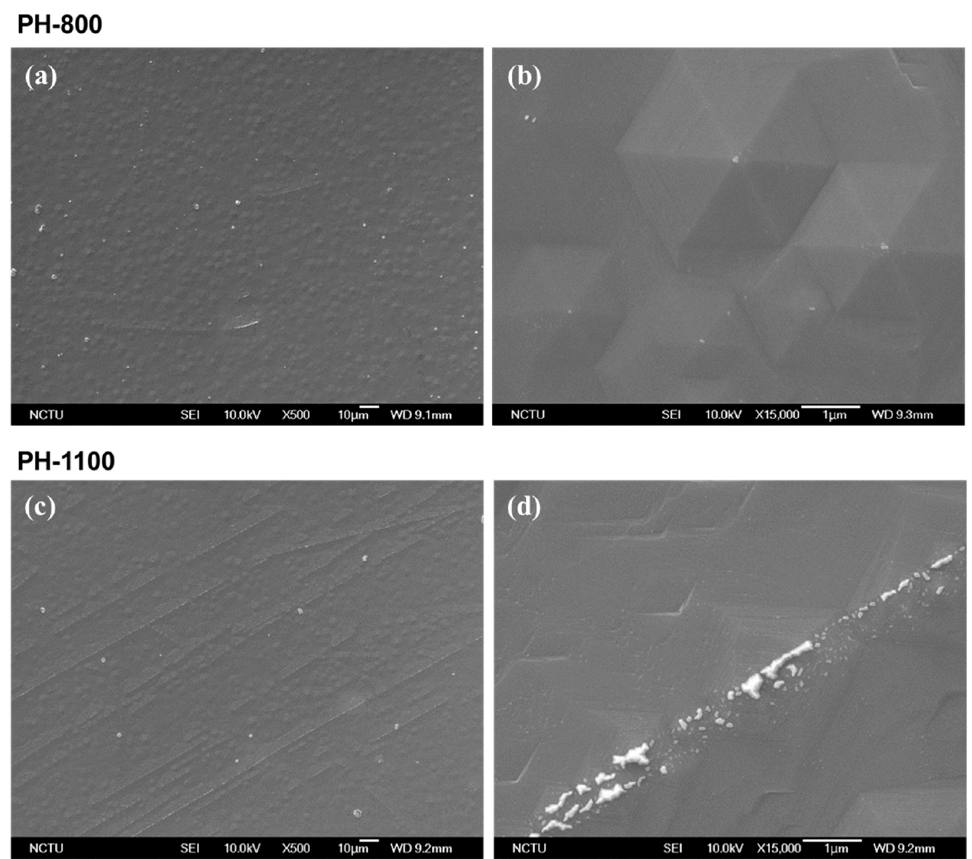
Figure 6. Plan-view SEM images of the GaN films on PH-800 with ( a ) 500× and ( b ) 15,000× magnification, and on PH-1100 with ( c ) 500× and ( d ) 15,000× magnification.